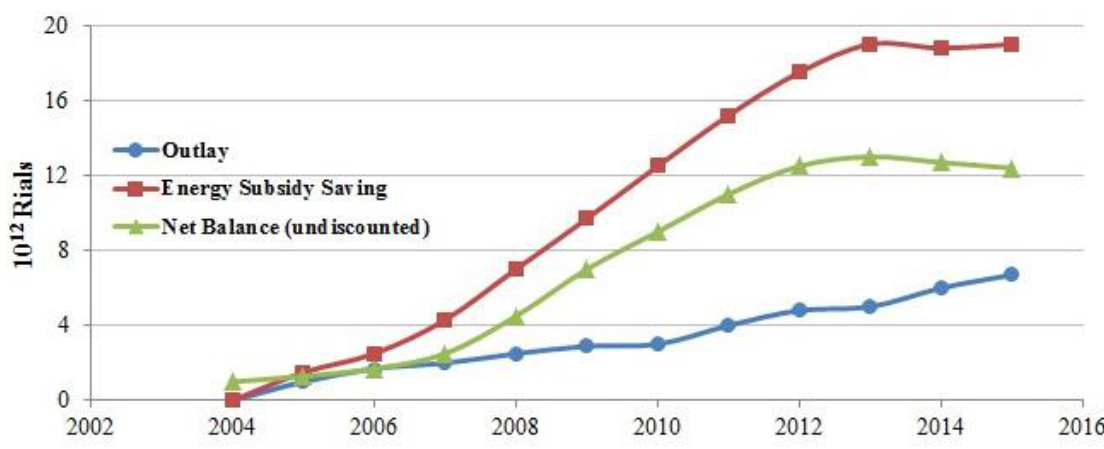
Figure 6. Net financial flows to the state without class C